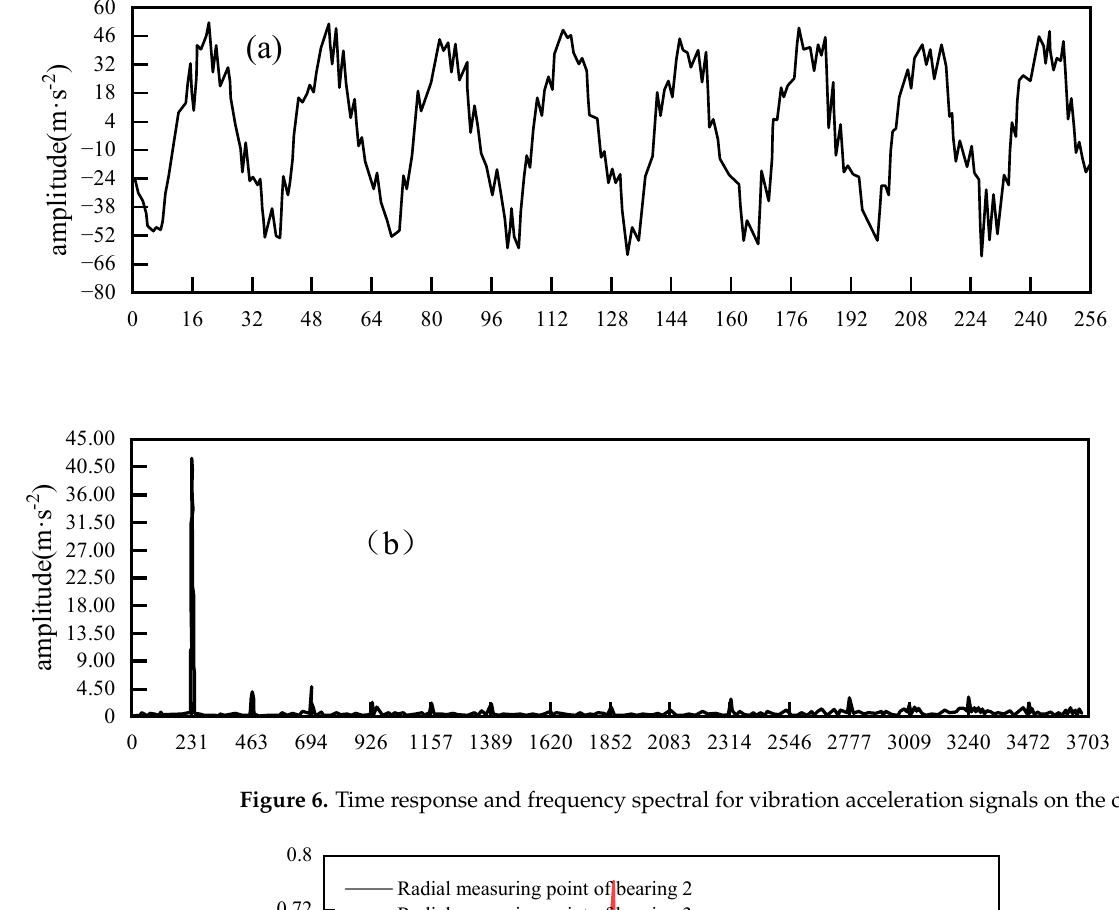
Figure 5. Time response and frequency spectral for rotating force signals. The acceleration varying with time is presented in Figure 6a, and the frequency spec- tral for acceleration data is shown in Figure 6b. The acceleration of the casing is excited by the exciter. The amplitude is about 40 m s − 2 and for every period.